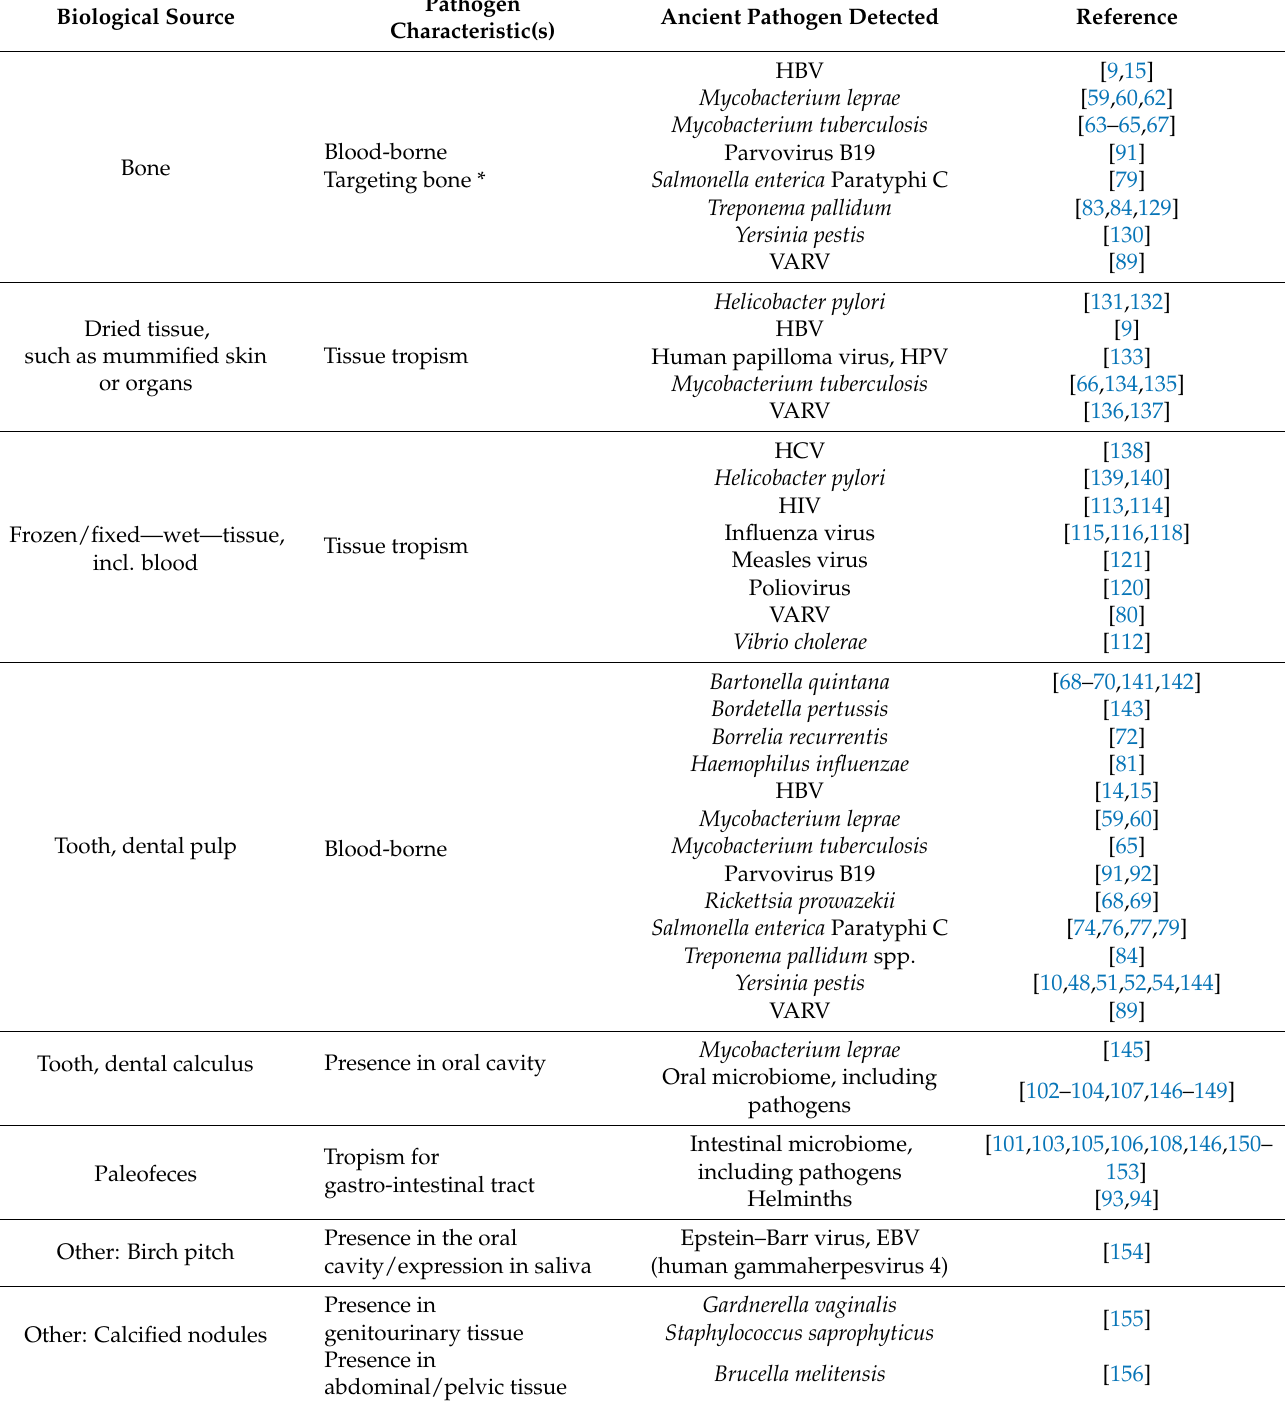
Table 2. Ancient pathogen nucleic acid retrieved from human